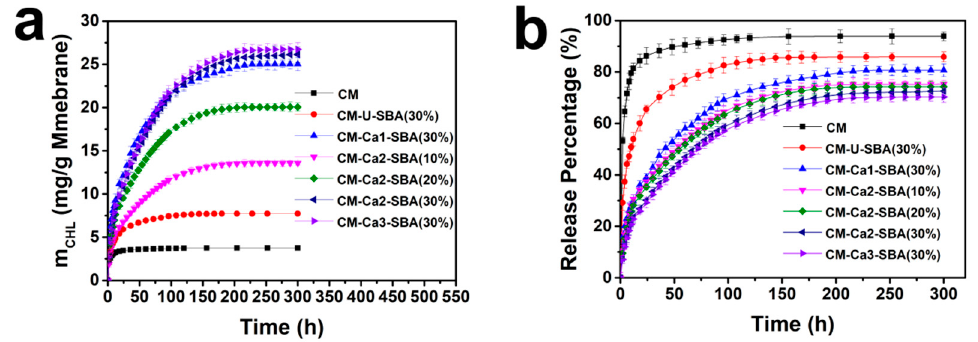
Figure 6. ( a ) Cumulative release mass and ( b ) release profile of chloramphenicol for different CM-based membranes in PBS.